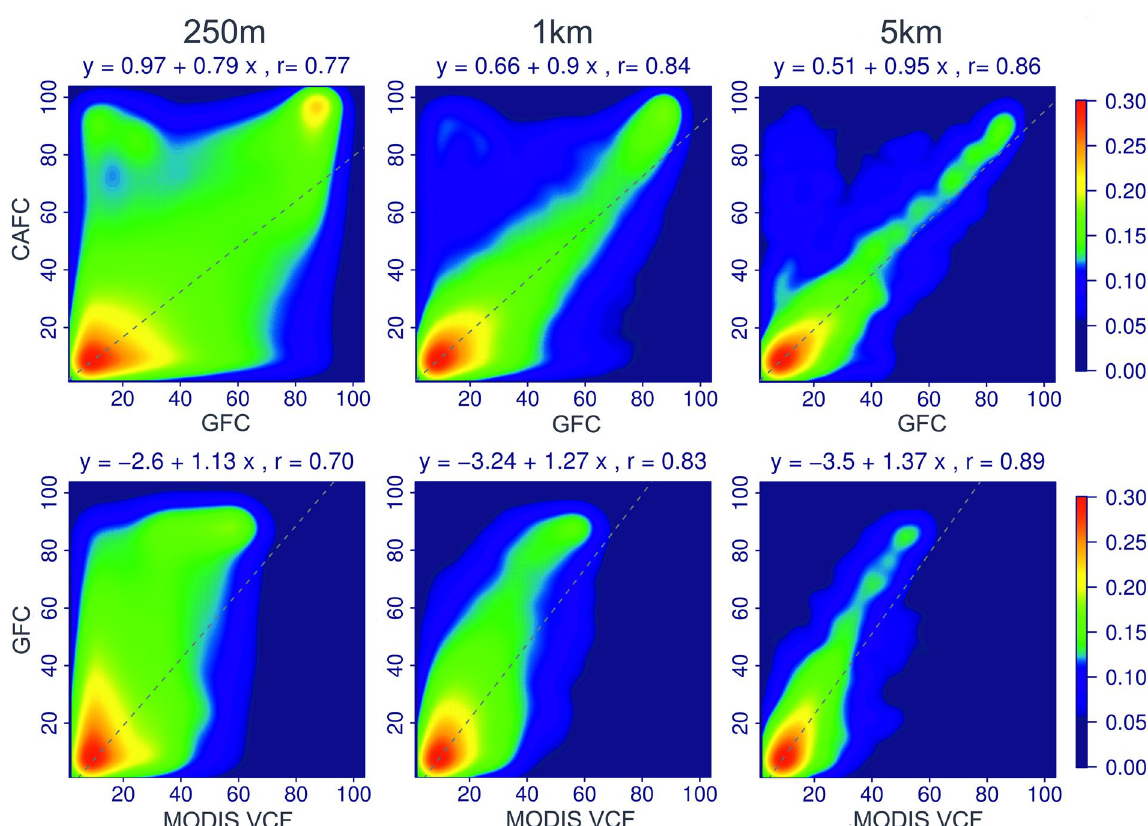
Figure 4. Joint distribution of forest cover percentage from CAFC vs. GFC (upper row) and tree cover percentage from MODIS VCF vs. GFC (lower row) at the sampling resolutions of 250 m, 1 km, and 5 km, with the colour scheme representing local densities at each point of the scatterplot (obtained through a kernel density estimate) and the dotted regression line demonstrating the coherence between different products.